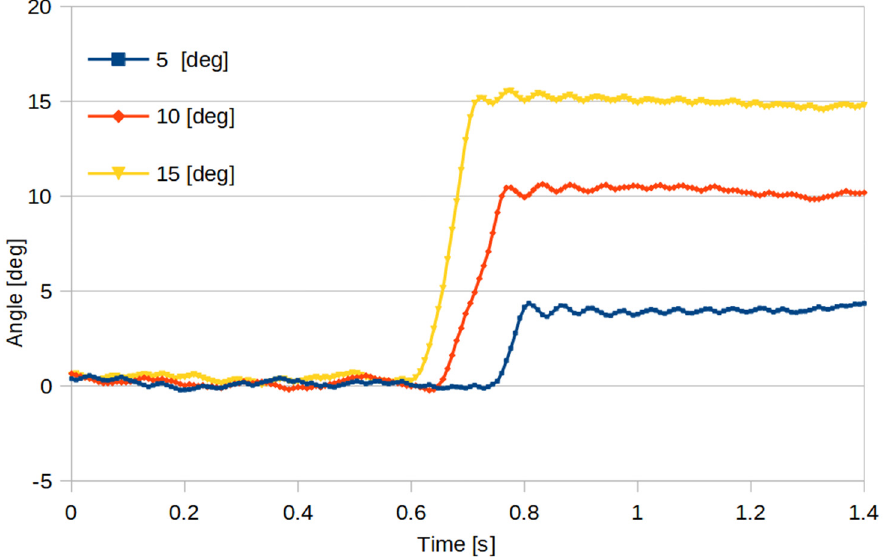
Figure 5. Time of change in position for angles as a function of time.